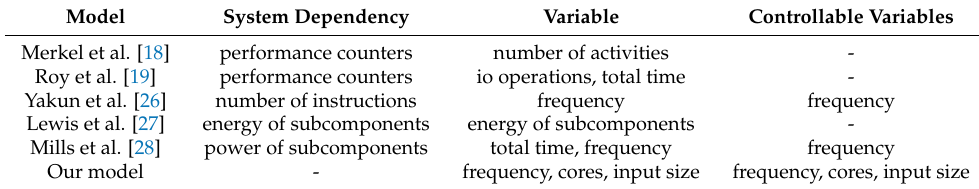
Table 1. Related work